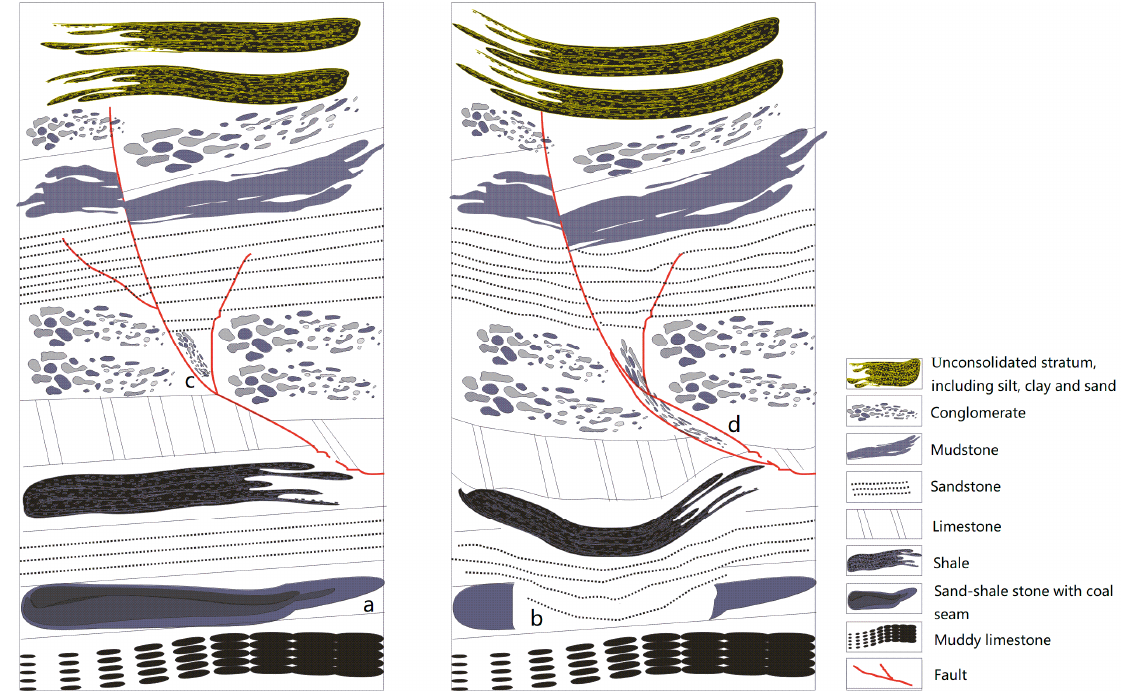
Figure 3. Sketch map of a coal mine after excavation with a fault system above. The lithology of each strata is illustrated in the legend, and the coal seam is in the penultimate layer ( a ). Besides, there is a fault system above the coal seam. When the coal seam ( b ) is extracted, the fault system is activated, and the fault breccia ( c ) further ruptures into ( d